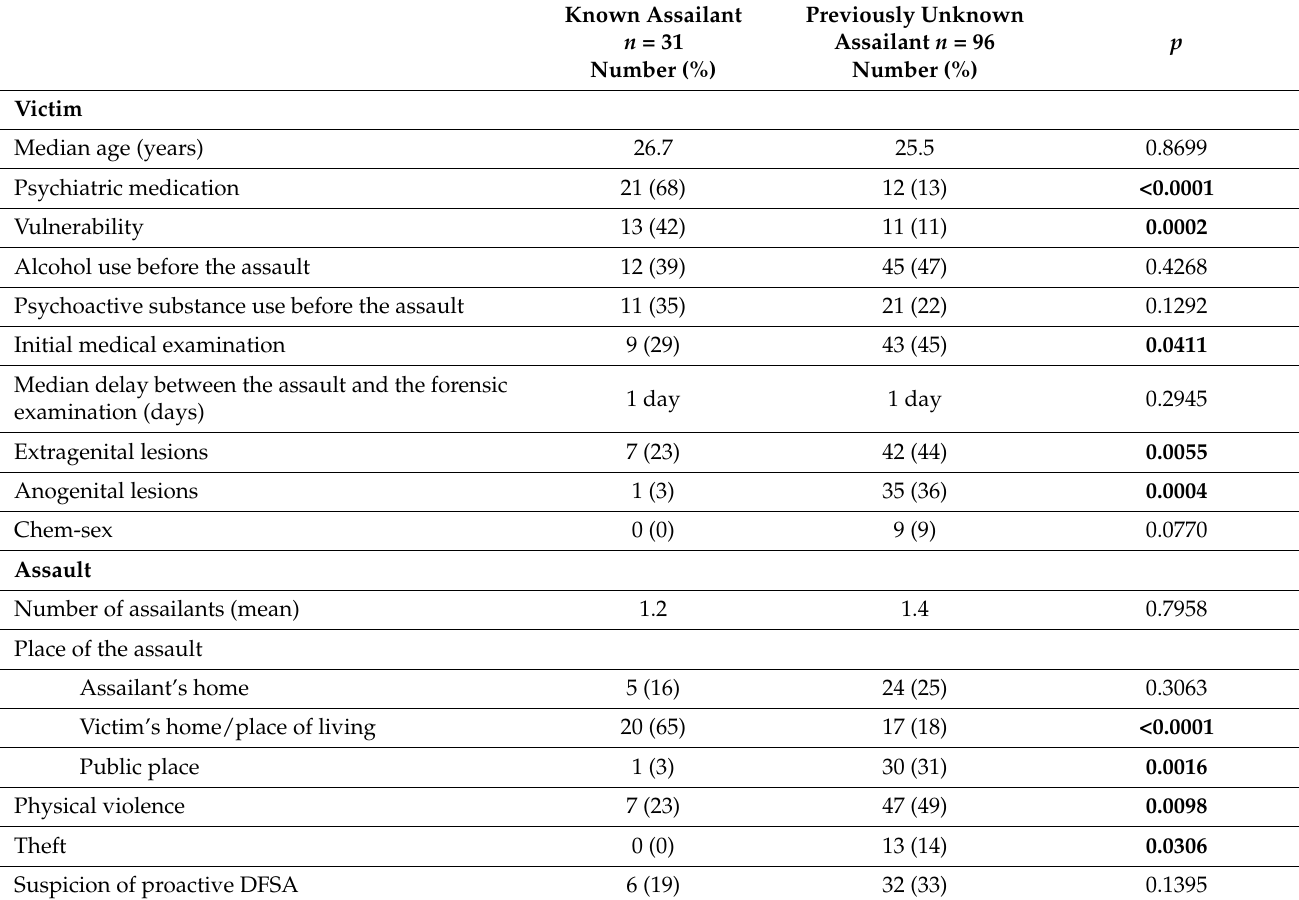
Table 4. Characteristics of the victim and the assault according to the assailant’s status. The bold number were for all p < 0.005